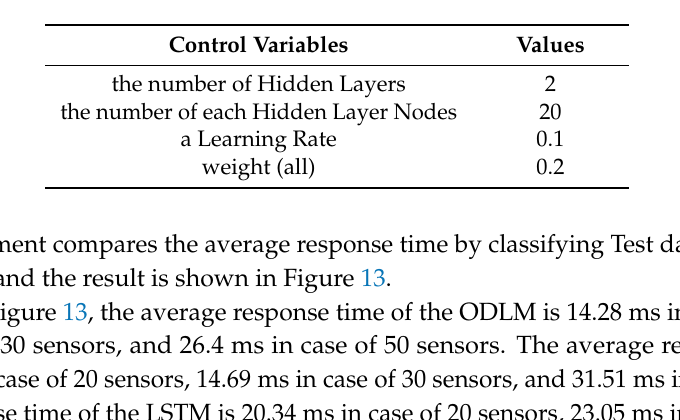
Table 3. A Control Variable Value for